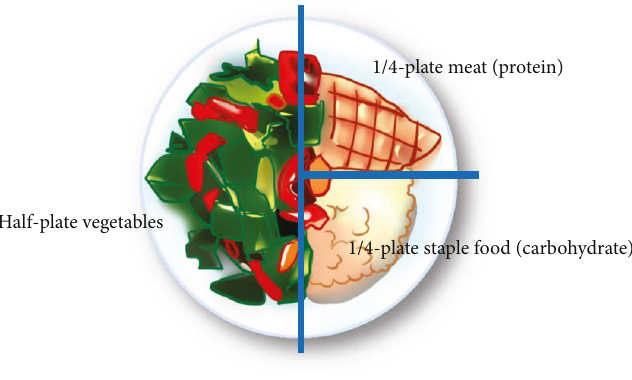
Figure 2: Restricted diet with a